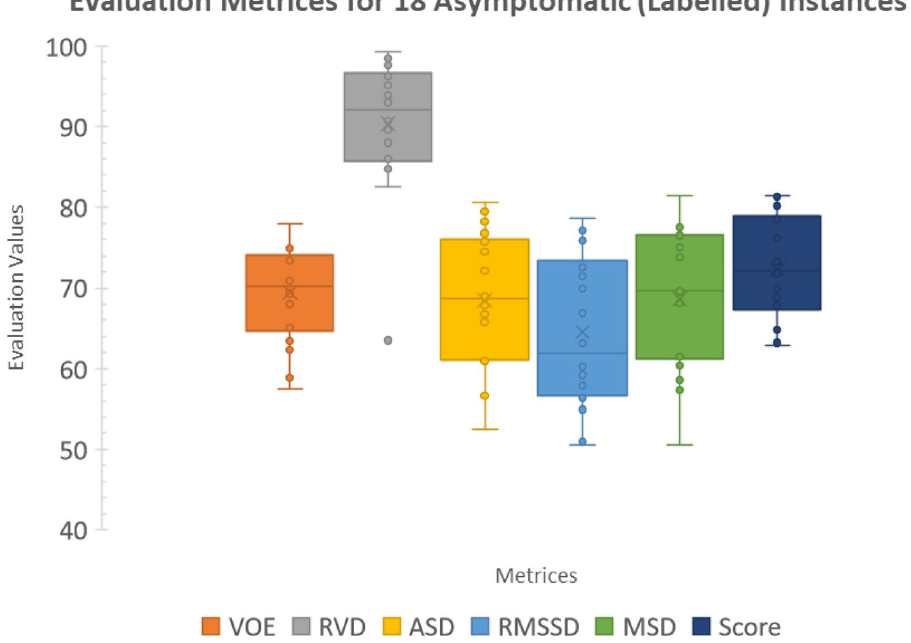
Figure 7. Box-Whiskers plots of VOE, RVD, ASD, RMSSD, MSD, and over scores for 18 asymptomatic images, drawn from labelled